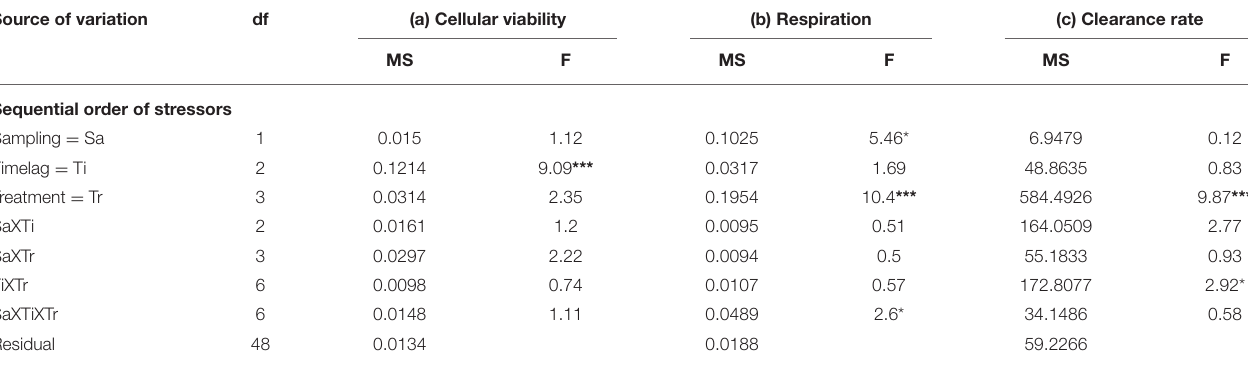
TABLE 4 | Analyses of the (a) cellular viability (optical density g − 1 haemocyte protein), (b) community respiration (mg O 2 l − 1 h − 1 ), and (c) clearance rates (l/h) of mussels/mussel assemblages at Malahide marina testing the influence of the sequential order of arrival of multiple stressors—the third subset of treatments described in the Materials and Methods ( n = 3 plots; data are untransformed; Cochran’s test: ns). Source of variation df